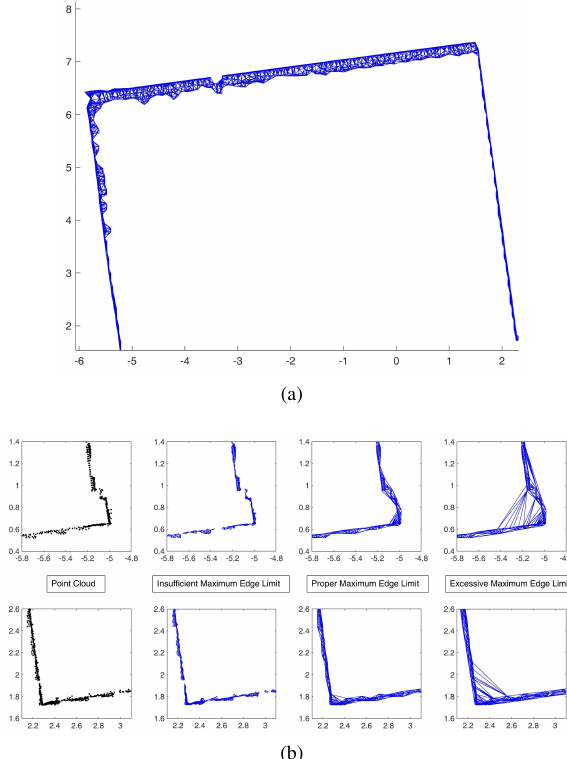
Figure 8: Delaunay Triangulation: (a) detail; (b) influence of the value of the MEL.